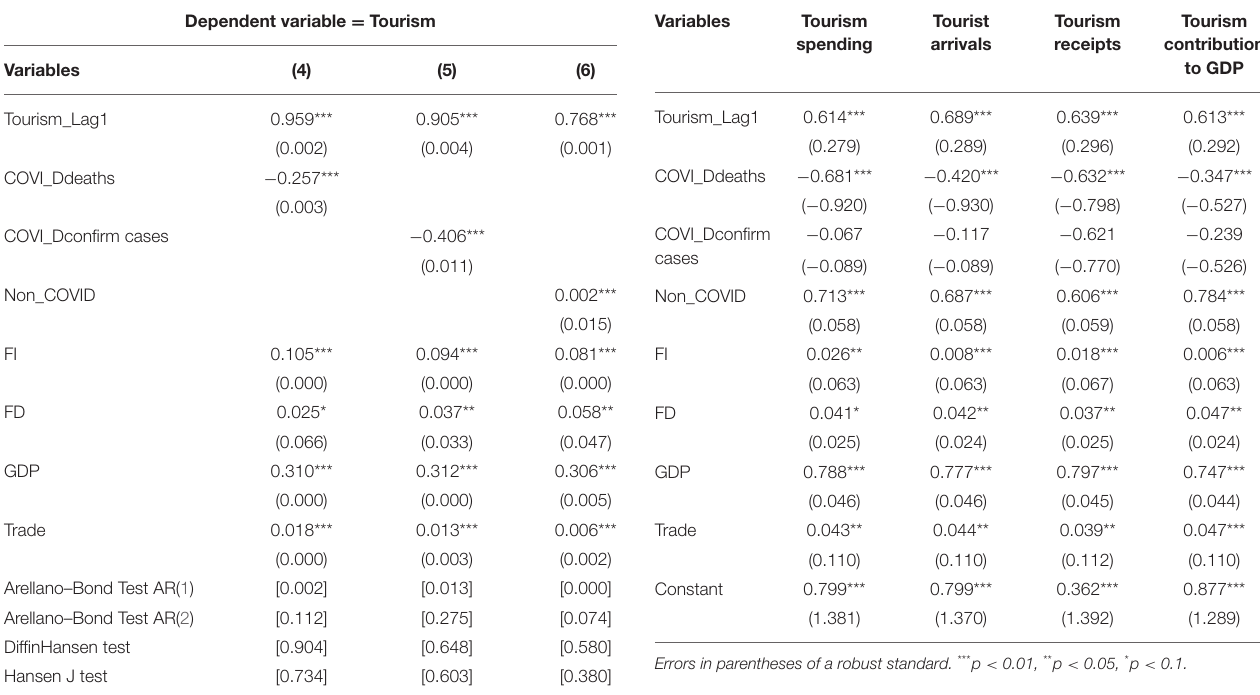
TABLE 3 | Effects of Health crises on tourism in developing countries. TABLE 4 | Robustness